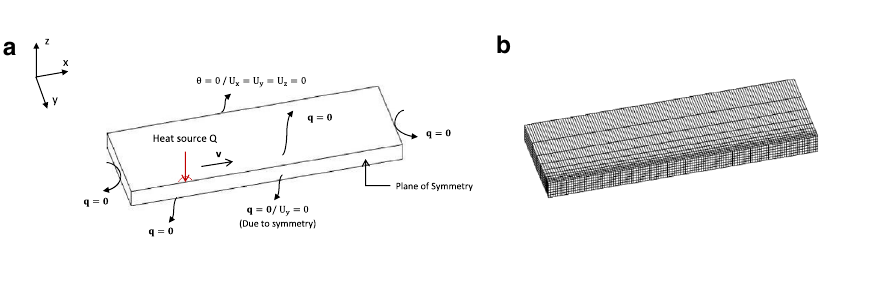
Fig. 6 Problem definition with boundary conditions. a Half model. b FE mesh